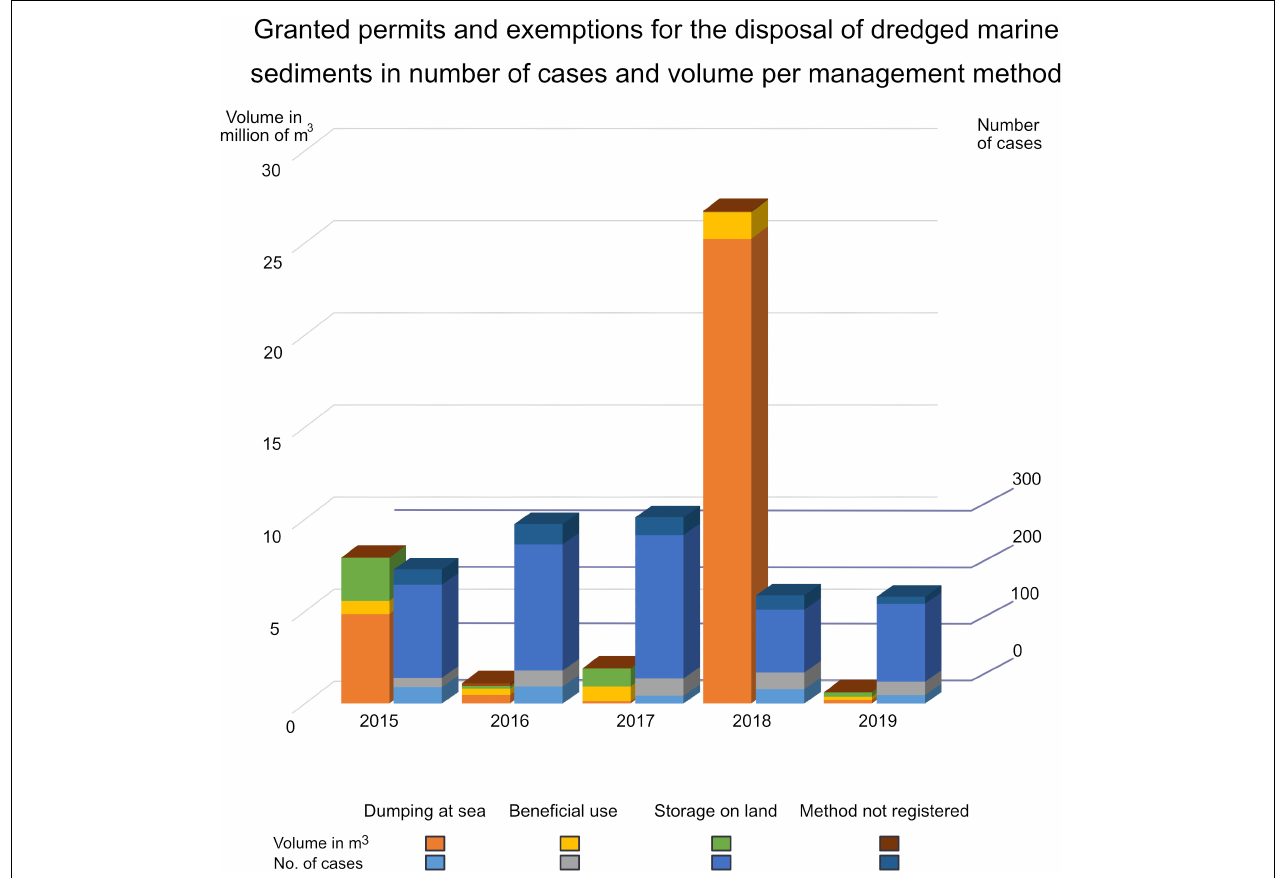
FIGURE 2 | Granted permits and exemptions for the disposal of dredged marine sediments in number of cases and volume between the start of 2015 and end of 2019. For some dredging projects several methods of disposal were registered, however, the distribution of volume was in general not reported. Therefore, the figure shows volume per method as if the respective method was used for 100% of the dredged sediment, thus showing the potential maximum volume. Since the requirements are strict for reporting dumping exemptions, the volume specifically for dumping ought to be